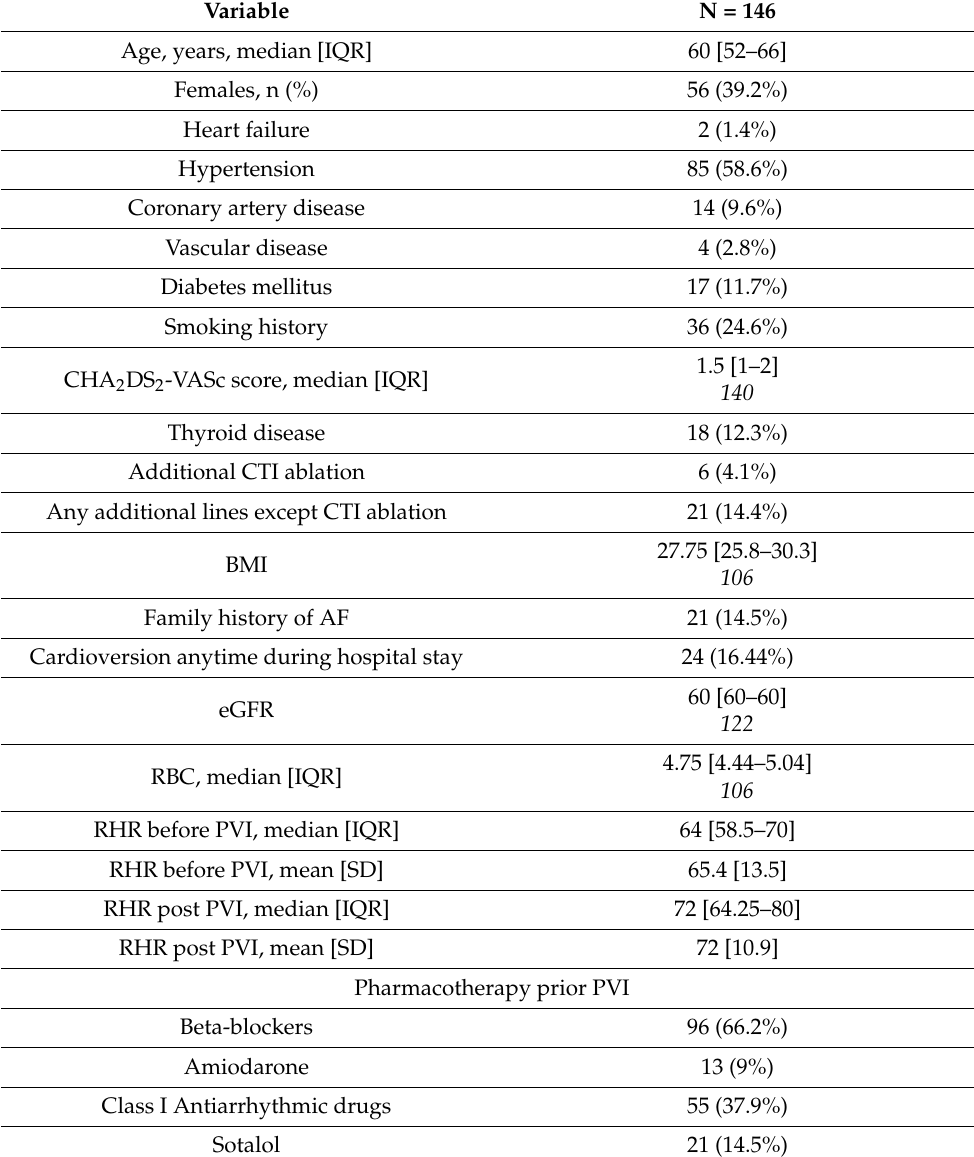
Table 1. Baseline